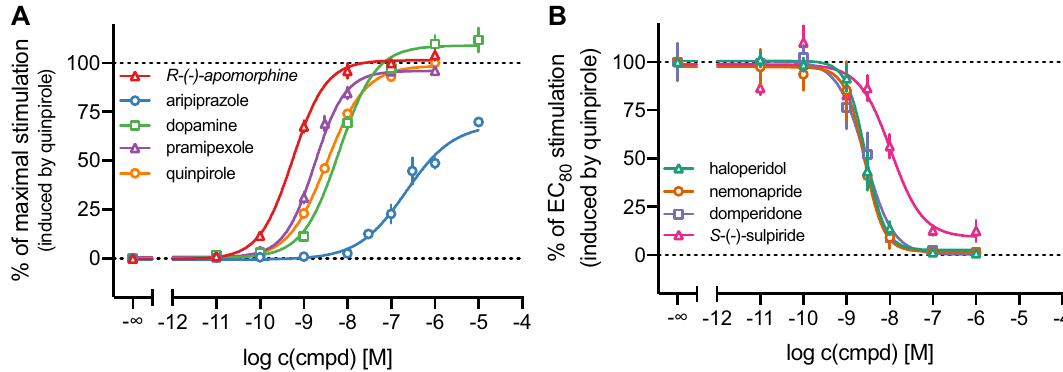
Figure 4. Characterisation of a set of reference DR agonists ( A ) and antagonists ( B ) in the DMR assay. CHO-K1 hD 2long R cells were treated with varying concentrations of the indicated ligands and the DMR signal was recorded over a time-course of 60 min. The maximum wavelength shift (Δλ max ) was used to construct concentration-effect curves. In agonist mode ( A ), the response was normalised to a solvent control (0%) and the maximum response induced by 1 μM quinpirole (100%). In antagonist mode ( B ), the cells were preincubated with various concentrations of antagonist for 30 min before quinpirole was added at a concentration (30 nM) that induces the response equal to 80% of the maximal response induced by 1 μM of quinpirole. The response was normalised to a solvent control (0%) and the response induced by 30 nM quinpirole (100%). Data represent means ± SEM of three independent experiments, performed in